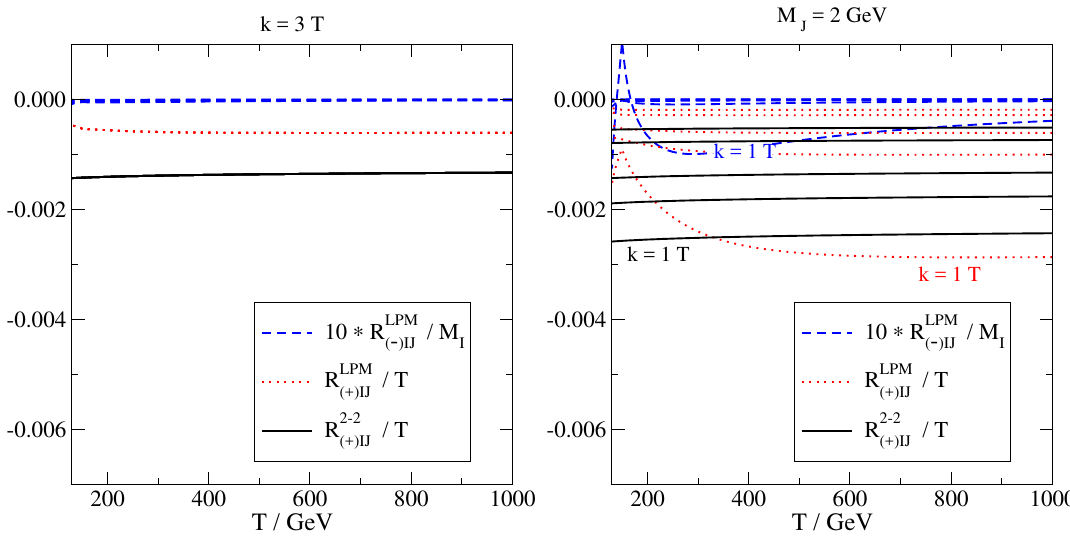
Figure 5 . Left: R from eq. (2.34), for (cid:12)xed k = 3 T and M /GeV 2 f 0 : 5 ; 1 ; 2 ; 3 ; 4 g . Mild mass ( (cid:28) ) IJ J dependence is seen in R , but R is very small once multiplied by M =T (cid:24) 10 (cid:0) 2 in order to ( (cid:0) ) IJ ( (cid:0) ) IJ I express it in the same units as the other contributions. Right: the same for (cid:12)xed M = 2 GeV and J k=T 2 f 1 ; 2 ; 3 ; 6 ; 9 g . One curve has been labelled, with the dependence on k=T being monotonic.